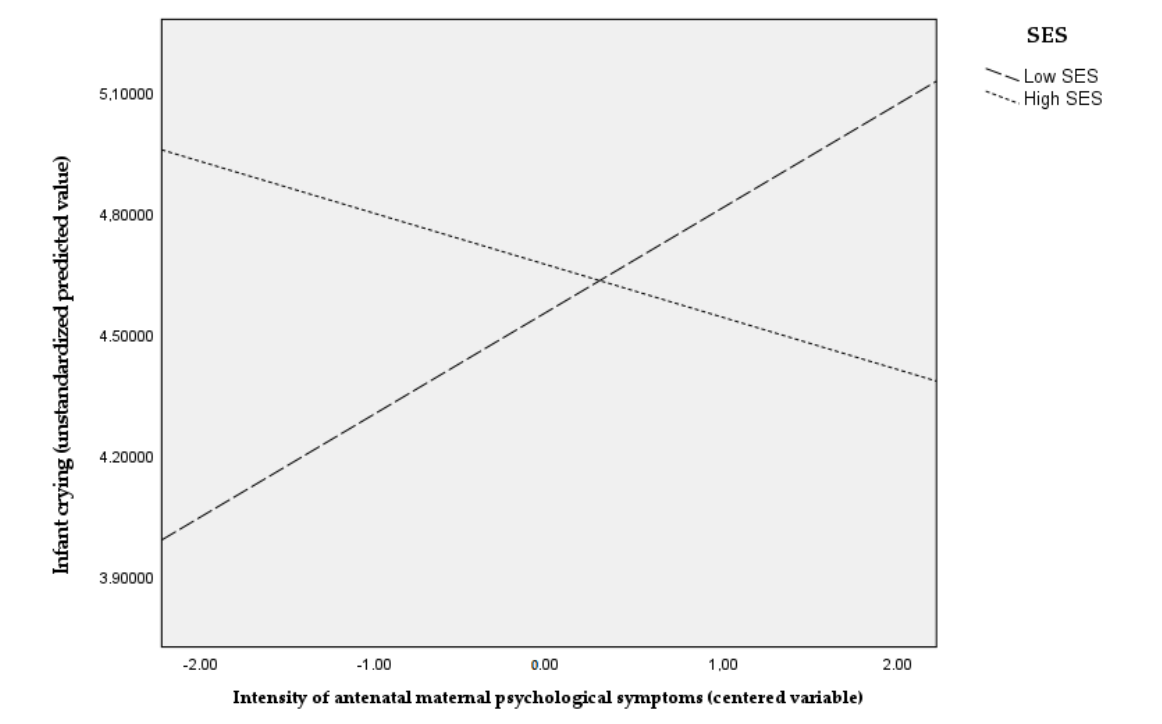
Figure 1. Graphical representation of the interaction effect (antenatal maternal psychological symptoms × SES) on infant crying.